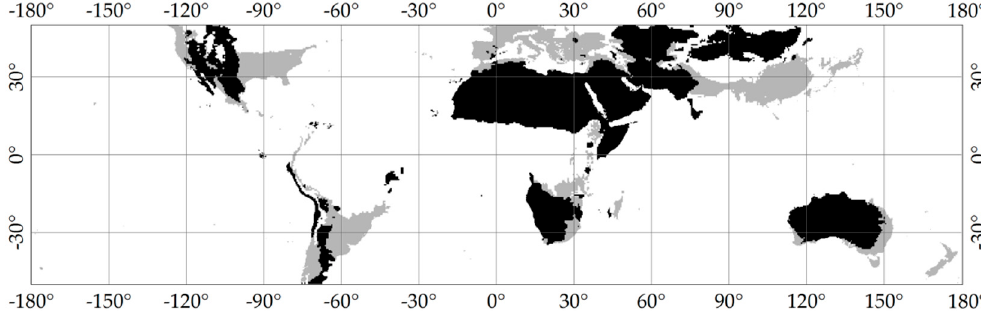
Figure A8. The ERDS macro-areas based on Koppen–Geiger climate classification: The different colours correspond to different corrective coefficients. The reference system is WGS84.